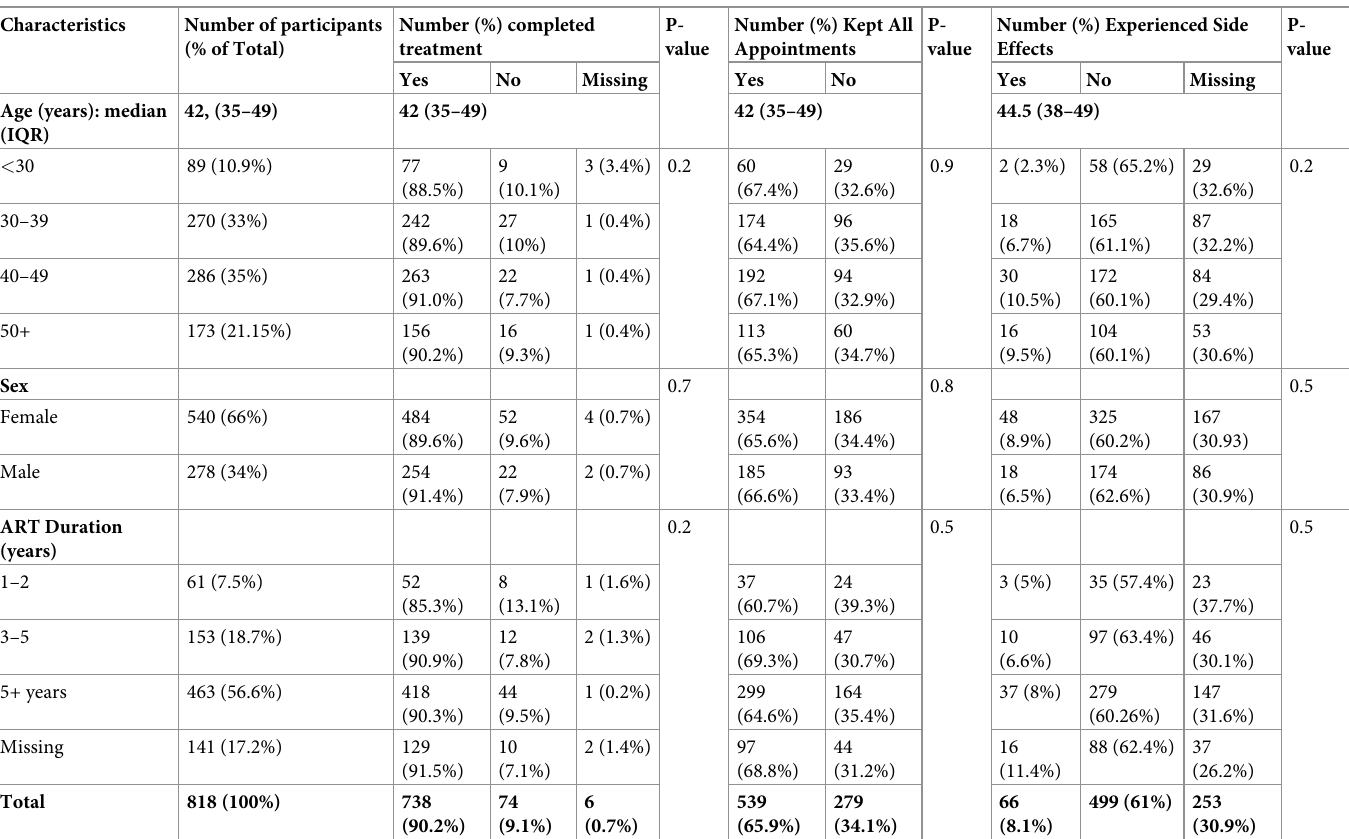
Table 1. Baseline characteristics and outcomes of enrolled participants.